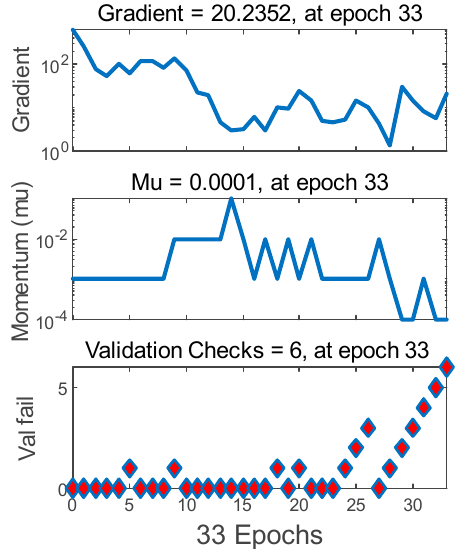
Figure 9. ANN training state.